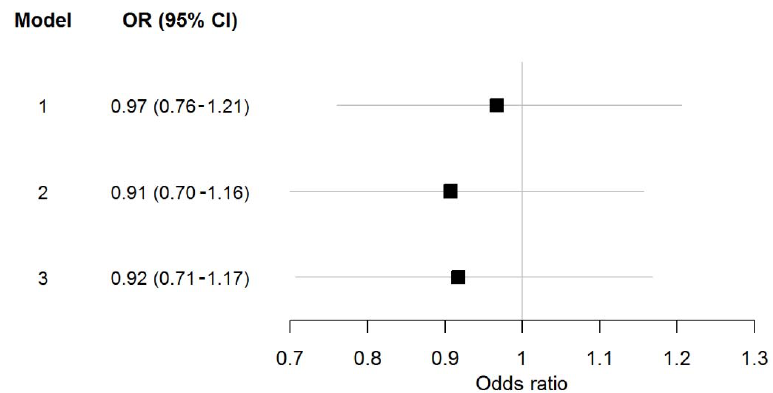
Figure 1. Multivariable-adjusted odd ratios for homoarginine per standard deviation increase in relation to atrial fibrillation (AF). Models: 1. Age- and sex-adjusted; 2. Risk factor-adjusted model including age, sex, body mass index, systolic blood pressure, antihypertensive medication, diabetes, active smoking, history of myocardial infarction, dyslipidemia, heart failure, and log creatinine; 3. Risk factor-adjusted model including age, sex, body mass index, systolic blood pressure, antihypertensive medication, diabetes, active smoking, history of myocardial infarction, dyslipidemia, heart failure, and heart rate. OR stands for odd ratios; CI for confidence interval.